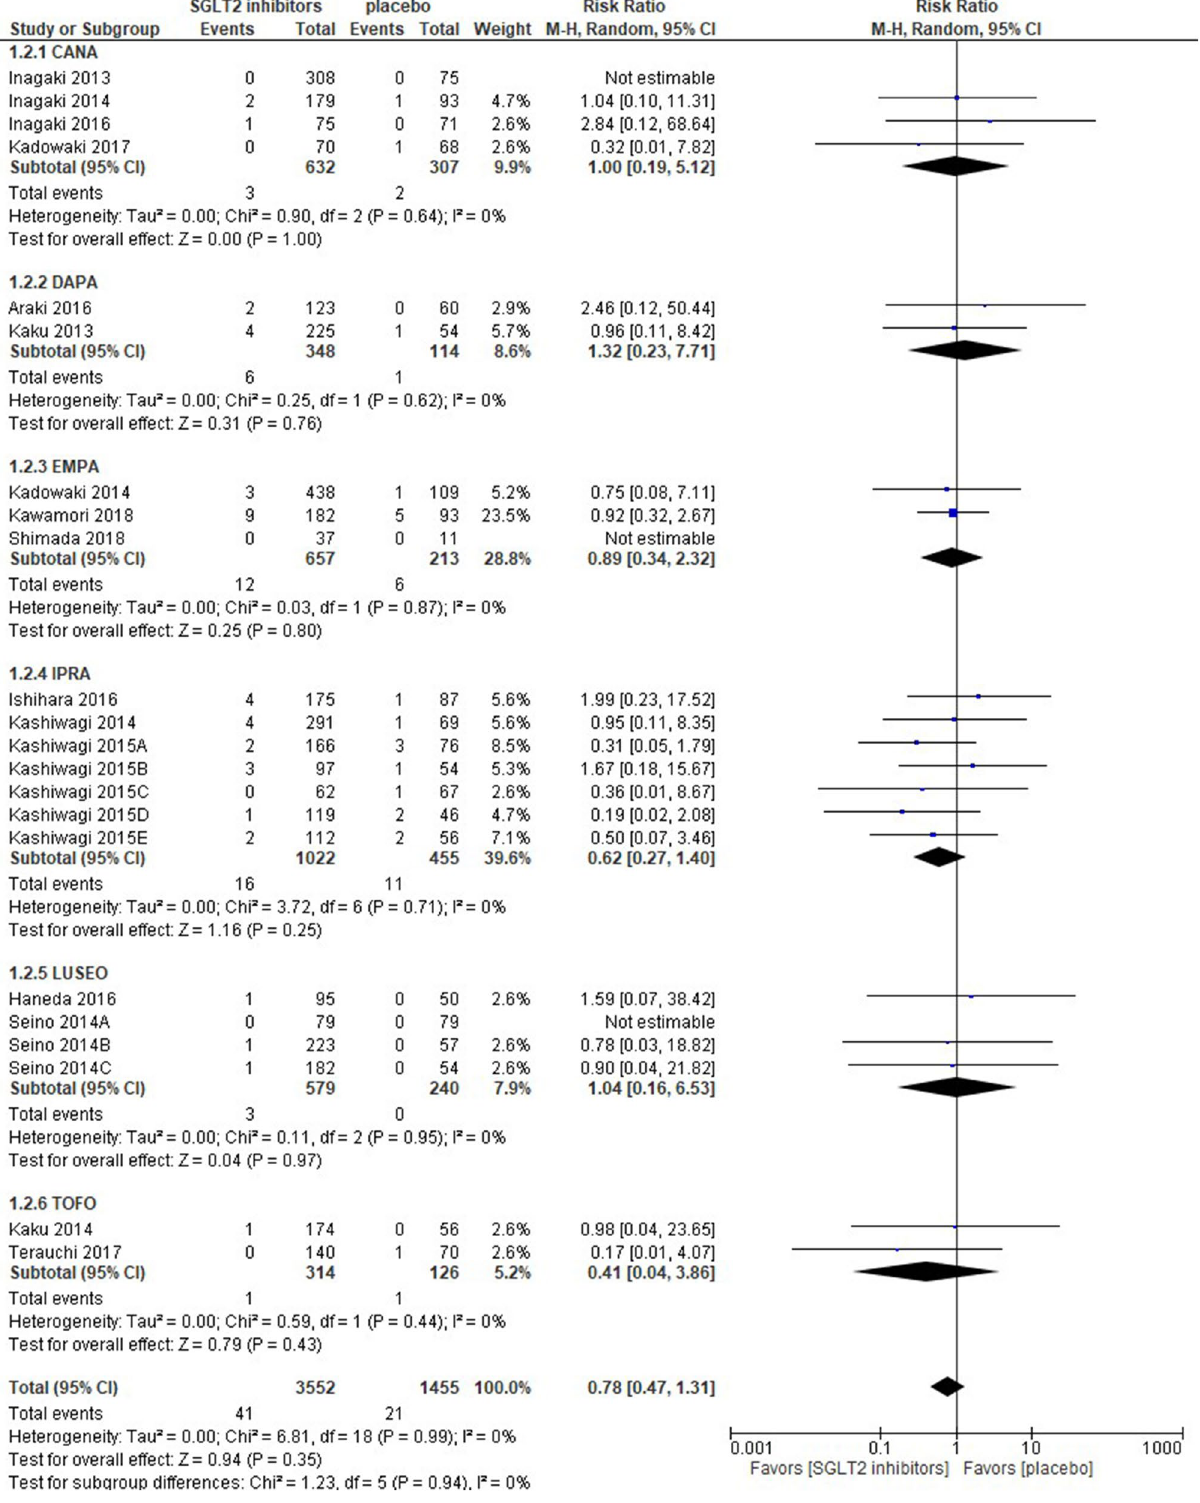
Figure 2. Forest plot for the risk of urinary tract infection. CANA canagliflozin, DAPA dapagliflozin, EMPA empagliflozin, IPRA ipragliflozin, LUSEO luseogliflozin, TOFO tofogliflozin, SGLT2 sodium-glucose co-transporter